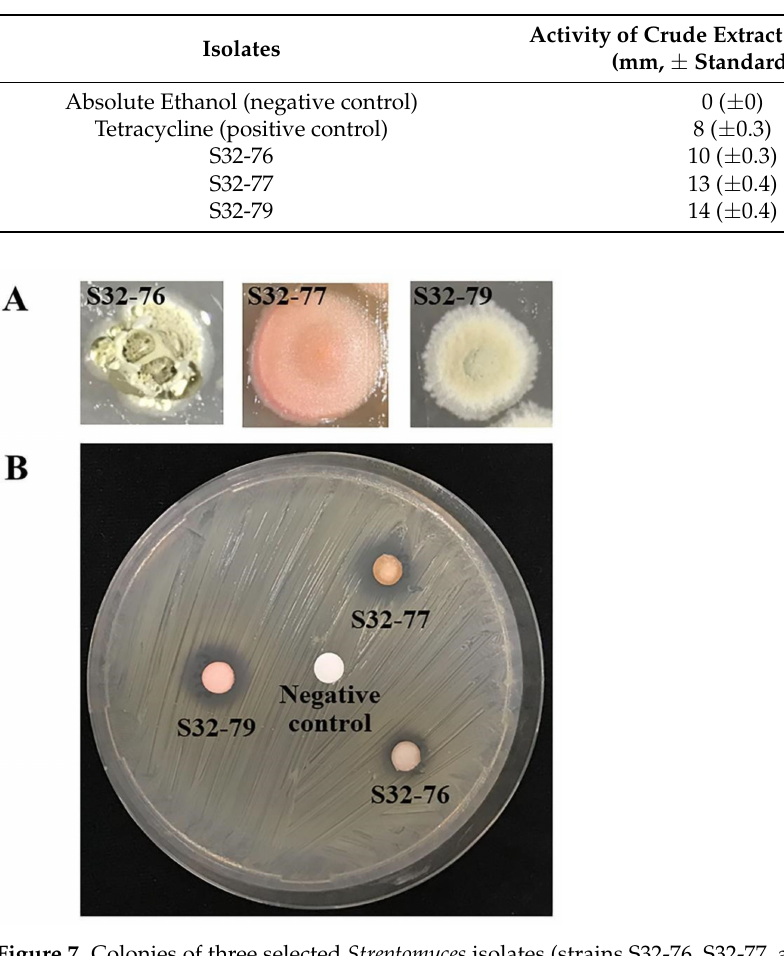
Table 5. The anti-MRSA activity measured after incubation for 3 days at 28 ◦ C on nutrient agar. The zone of inhibition indicated activity against the growth of MRSA. Each disk contained 1.6 mg of crude extract.